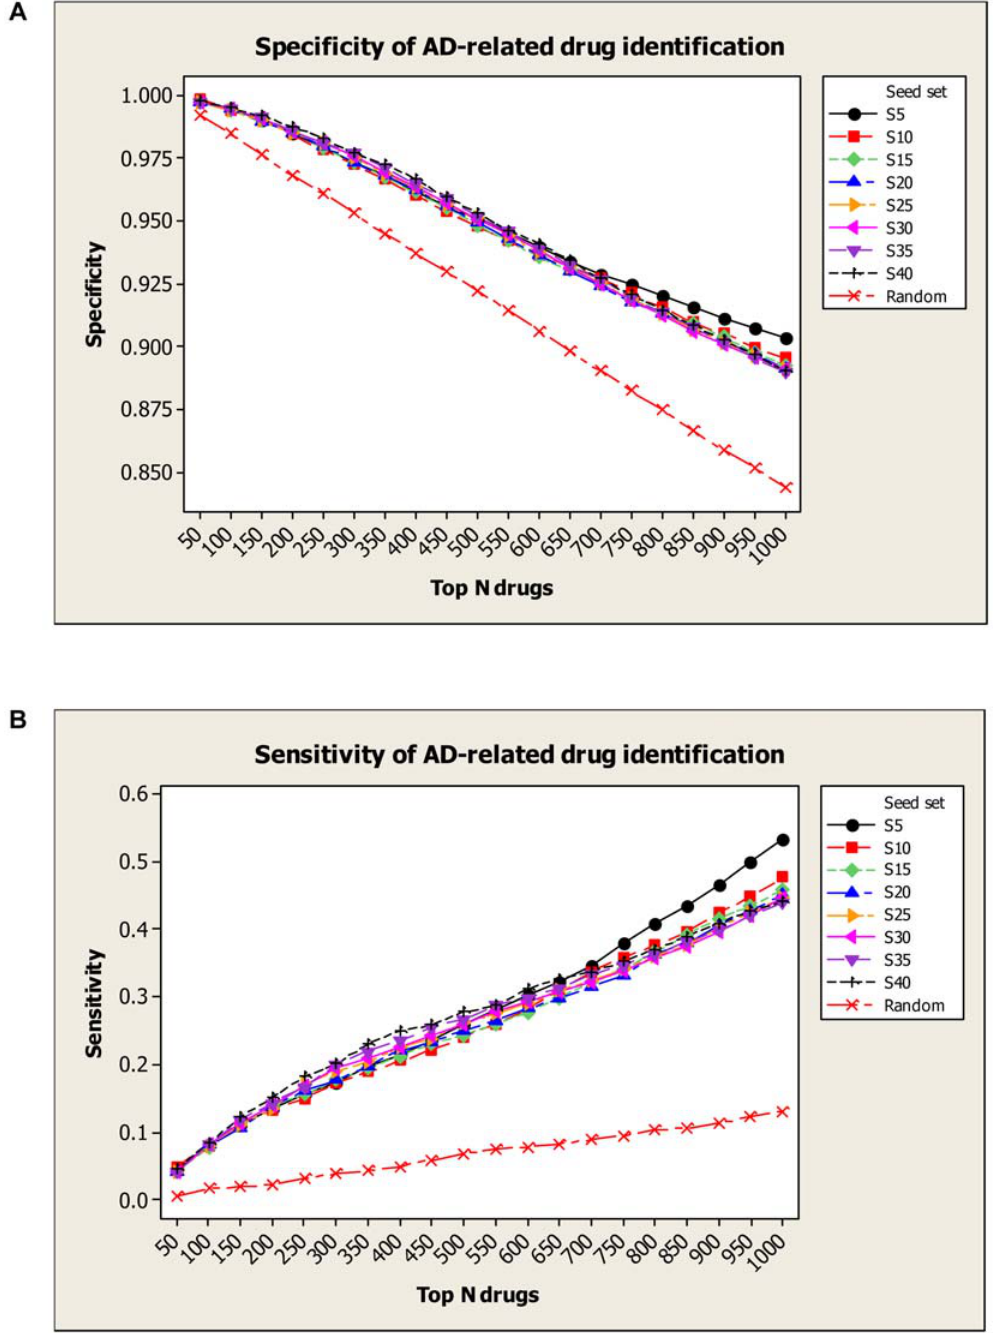
Figure 3. The effect of different disease-related protein seeding situation on the specificity and sensitivity of AD drug identification. In the text retrieval and information extraction component, the AD-related drugs are identified from the retrieved PubMed abstracts relevant to a list of AD proteins. We have an initial set of 49 AD seed proteins. To evaluate the effect of different seeding situations on AD drug identification, we sub-sampled the initial AD seed set into 8 data sets of varying sizes i.e., S5, S10, S15, S20, S25, S30, S35, S40 (the number indicating size) and also generated a random seed set with 50 proteins.. Given different seed sets, Panel (A) shows the specificity performances of AD-related drug identification at top N drugs determined by FDR (false discovery rate), and Panel (B) shows the sensitivity